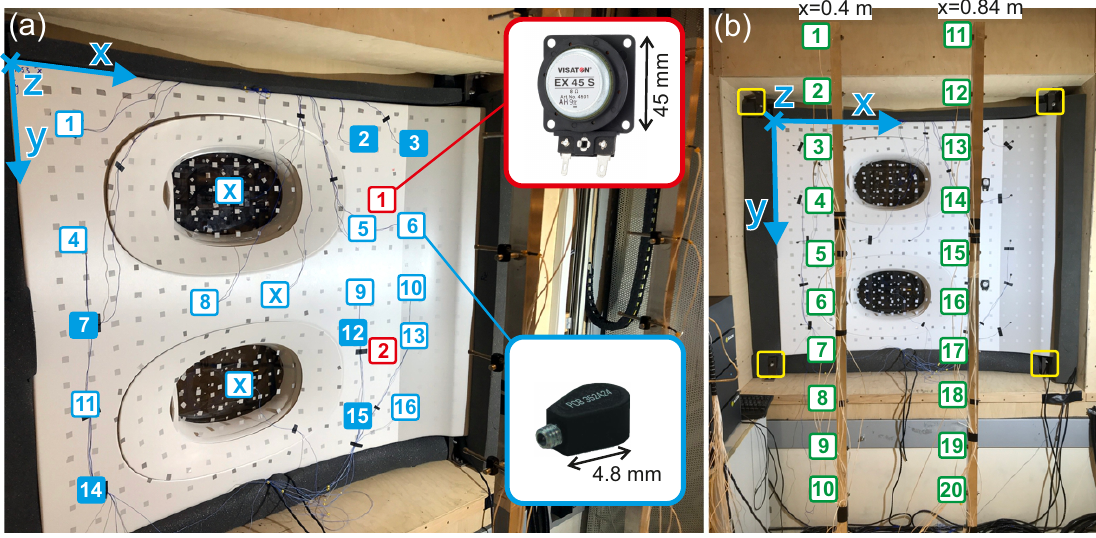
Figure 2. Experimental setup in the transmission loss facility seen from the semi anechoic room. The locations of the actuators and the accelerometers are indicated in (a) and the microphone locations are indicated in (b). The accelerometers are indicated in blue, the actuators in red and the microphones in green. The accelerometers finally chosen as remote sensors are 2, 3, 7, 12, 14 and 15 (blue backed boxes). The microphones are positioned z = lining along two vertical lines at x = 0.4 m and x = 0.84 m spanning two planes used for control performance evaluation.